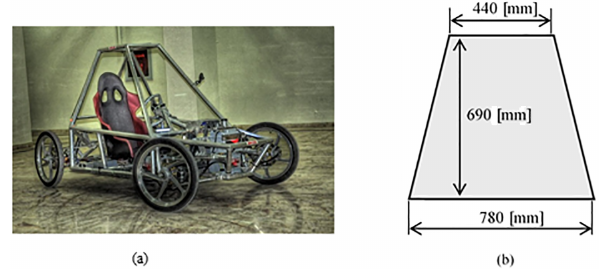
Figure 4. (a) L7e car chassis (Tanık and Parlakta¸s, 2015), and (b) windscreen dimensions.